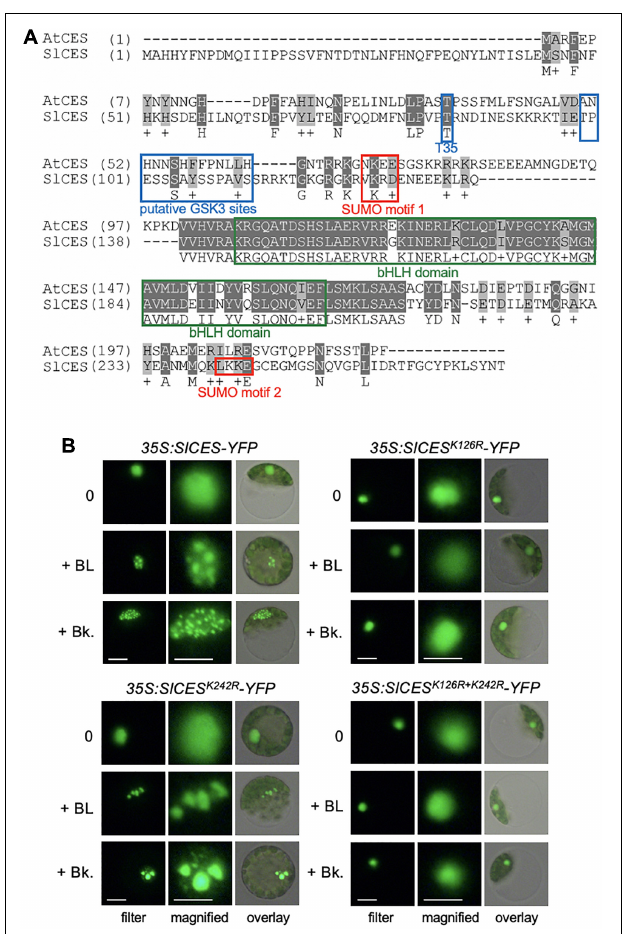
FIGURE 1 | Solyc12g036470 encodes a CES orthologue, which enriches in subnuclear domains in response to BR. (A) Amino acid sequence alignment of CES of A. thaliana (AtCES) and CES of S. lycopersicum (SlCES). Motifs with functional relevance in AtCES are highlighted. (B) SlCES-YFP wild-type and SUMO mutant versions were expressed under control of the 35S promoter in tomato mesophyll protoplasts, which were either left untreated (0) or treated with 1 µ M of the BR 24-epibrassinolide (+ BL) or 1 µ M of bikinin (Bk). The images show CES-YFP localization in representative protoplasts, analyzed and imaged with fluorescence microscopy. White scale bars: filter = 10 µ m, magnified = 6 µ